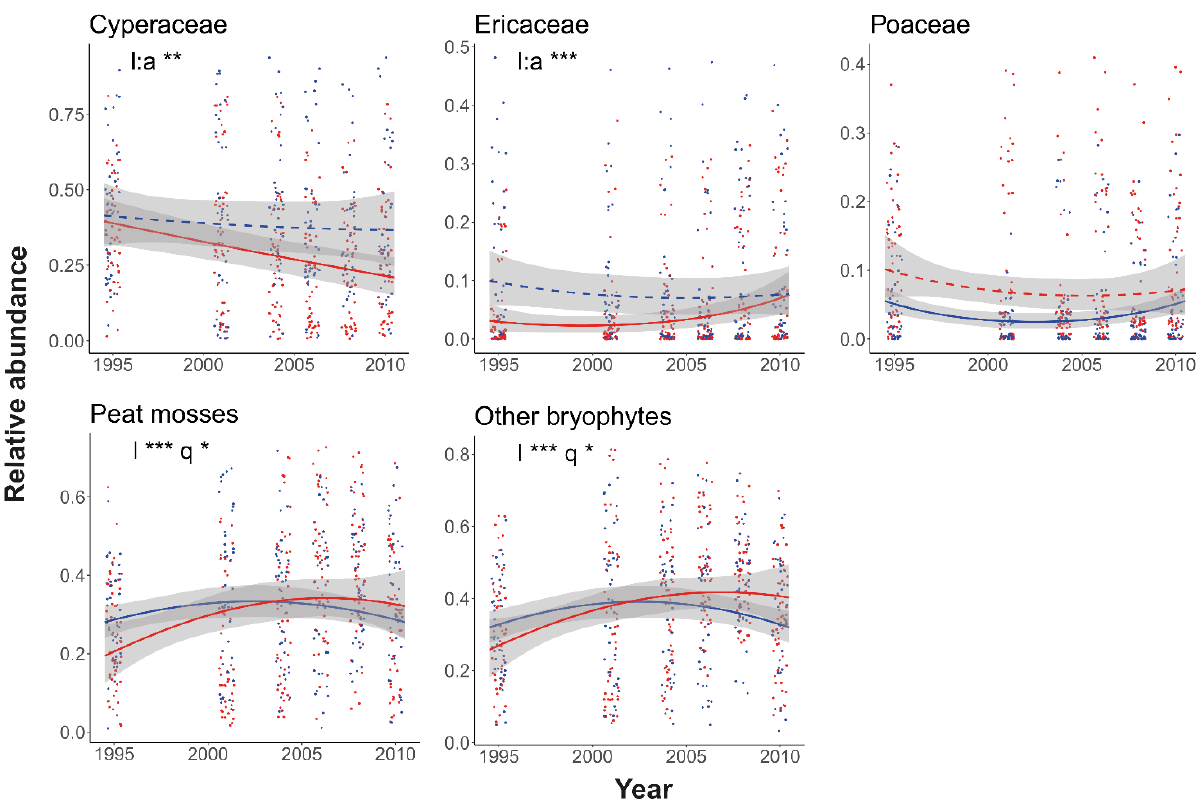
Figure 7. Trends of the relative abundance of taxonomic groups for GC-areas (grazing cessation, red) and GCR-areas (grazing cessation plus rewetting, blue). Regression lines and confidence intervals from individual models are displayed. Solid lines show significant trend components. Dashed lines show the model fit of both trend components, if neither of them is significant. Labels denote significant trend differences or significant overall trends derived from the common model. Dots indicate observed values on single plots. Outliers are not shown. l = linear time component; q = quadratic time component; a = area type; a colon indicates an interaction. Significance levels: *: p ≤ 0.05; **: p ≤ 0.01; ***: p ≤